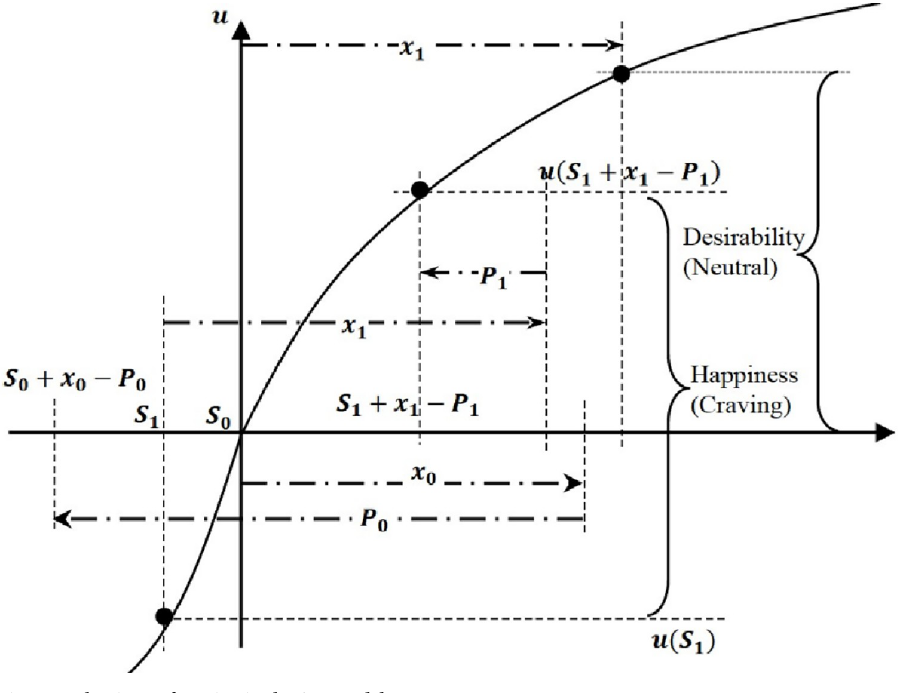
Fig 2. Mechanisms of craving in the AM